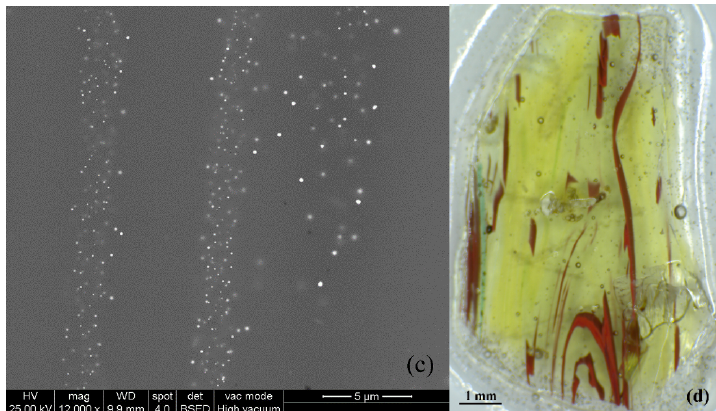
Figure 12. SEM-BSE ( a – c ) and OM ( d ) images of the copper-phases opacified tesserae showing ( a ) euhedral cubic nanocrystals of metallic copper (tessera PN M2); ( b ) sub-rounded crystals of cuprite (PN AV1); the bright drop is metallic copper; ( c , d ) micro-texture of green/red tessera PN M3 characterized by metallic copper crystals in opaque red stripes and absence of opacifier in translucent green stripes.